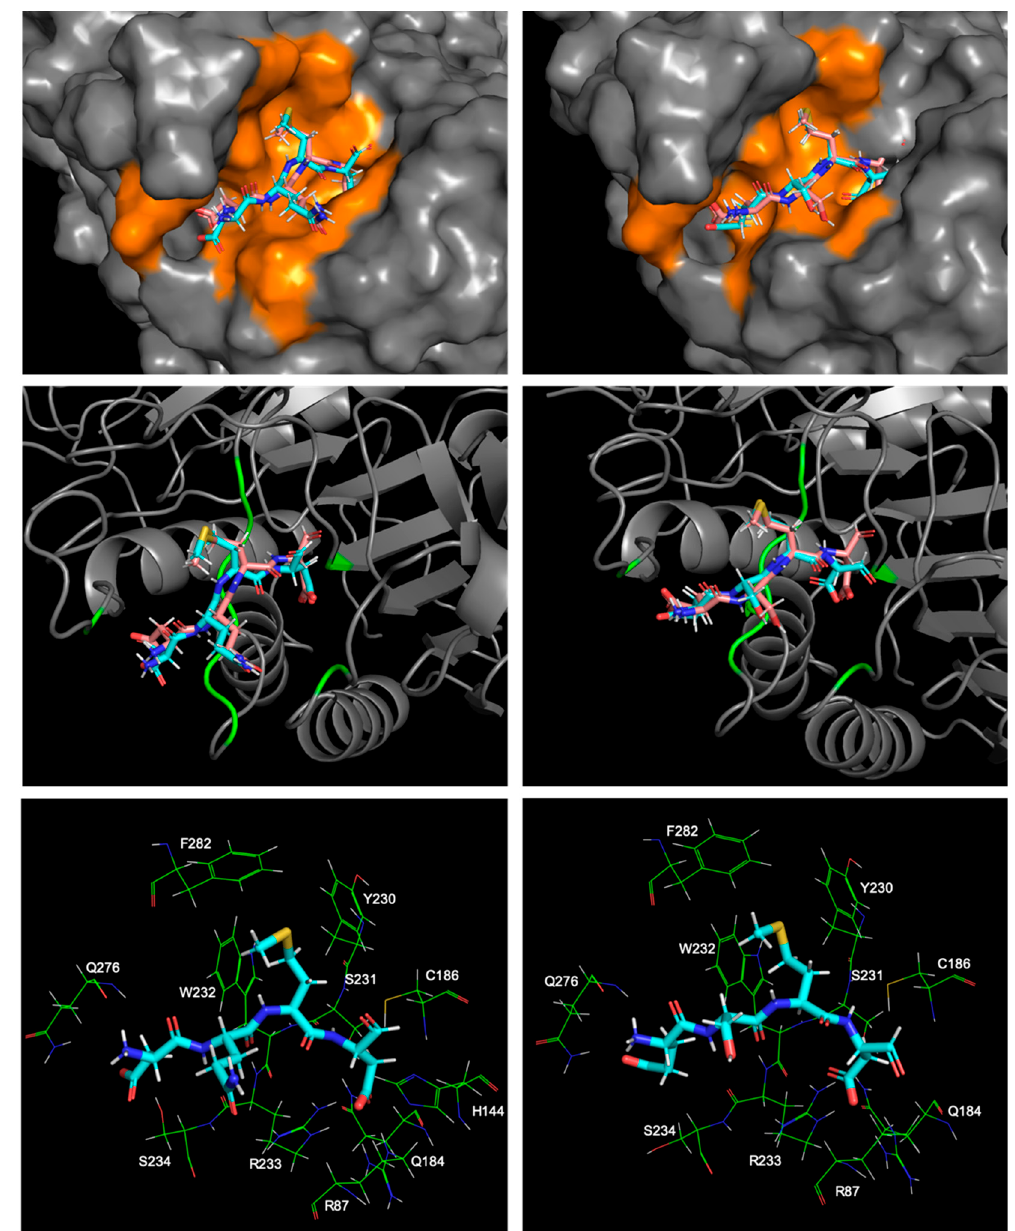
Figure 9. Illustrations of the caspase-7 binding site with Ac-DQMD-Cho (pictures on the left) and Ac-ESMD-Cho (pictures on the right). The global minimum docked pose (cyan) are shown together with the crystal ligand conformation (pink). Orange regions on both binding sites shows the difference of the contacts areas. The green ribbons also indicate more residues from the caspase-7 binding site having significant contact with Ac-DQMD-Cho compared to Ac-ESMD-Cho. Pictures on the bottom show that the glutamine residue from Ac-DQMD-Cho forms extra hydrogen bonds to the R233 residue at the caspase-7 binding site, while no hydrogen bond can be found at the same location for the caspase-7-Ac-ESMD-Cho complex.